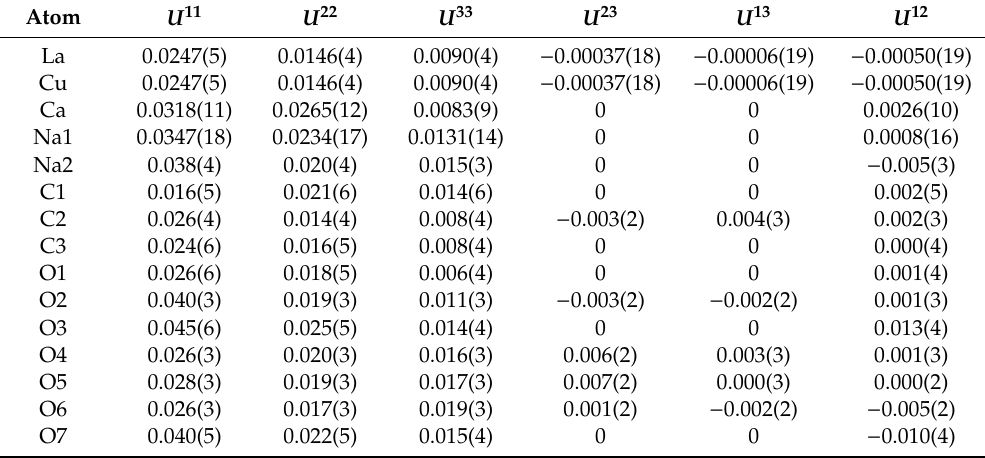
Table 4. Anisotropic displacement atom parameters for paratooite-(La) (Å 2